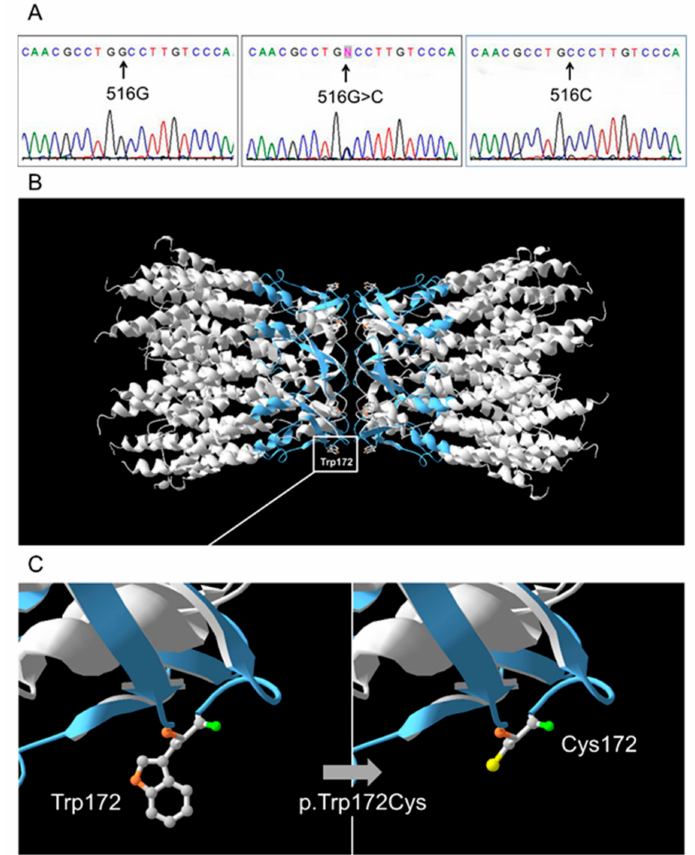
Figure 1. ( A ) Identification of the c.516G > C (p.Trp172Cys) mutation by Sanger sequencing. ( B ) The